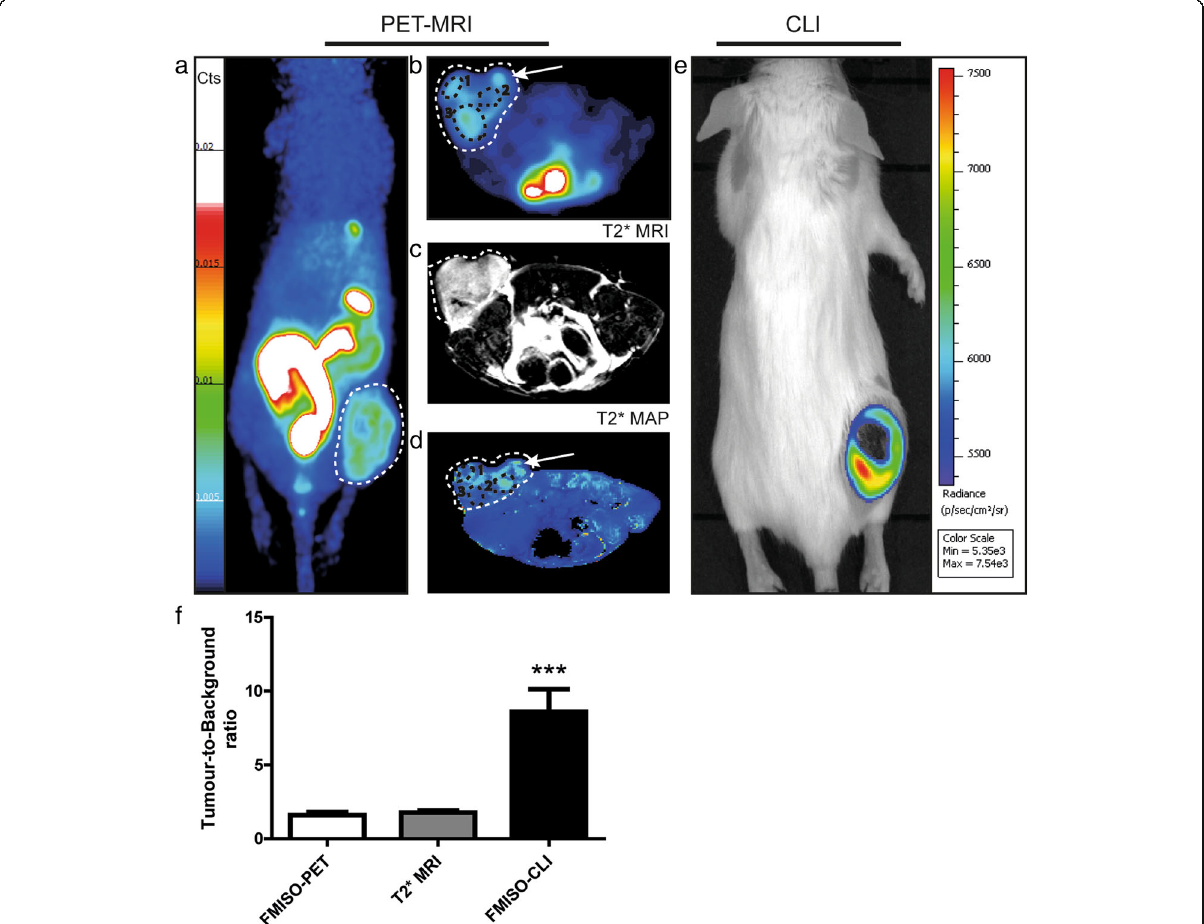
Fig. 2 Imaging of hypoxia within CT26 tumour bearing mice ( n =13), PET-MRI a – d Representative PET-MRI images showing the global co-localisation of FMISO uptake and BOLD MRI signal. Images were acquired 120 min post-injection of 10 MBq of [ 18 F]-Fluoromisonidazole (FMISO). PET. a Representative maximum-intensity-projection FMISO PET Image; b Transversal slice showing FMISO uptake within the tumour; c T2*- weighted MRI and d BOLD image derived from T2* mapping. White dashed lines: tumour limits, white arrows: oxygenated tumour area (increased BOLD signal), black circle: hypoxic tumour areas (decreased BOLD signal). CLI ( e ): Representative FMISO CLI image of the same mouse as for a to d acquired just after the PET-MRI scan. f Tumour-to-background ratio for PET, MRI and CLI following the injection of FMISO determined by the ratio of the signal from the tumour and a contralateral irrelevant region of interest (muscle); n =13, *** p